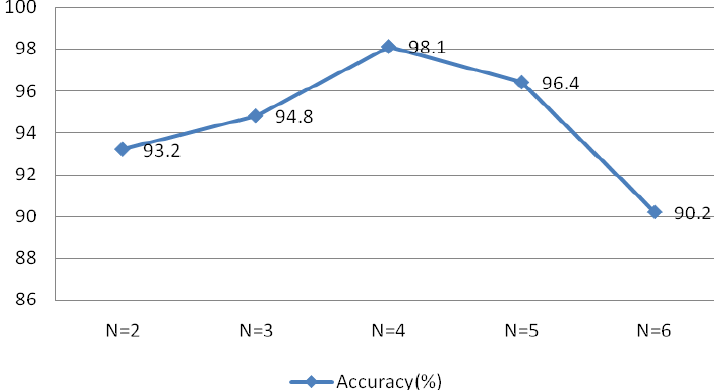
Figure 23. Performance with Different Numbers of